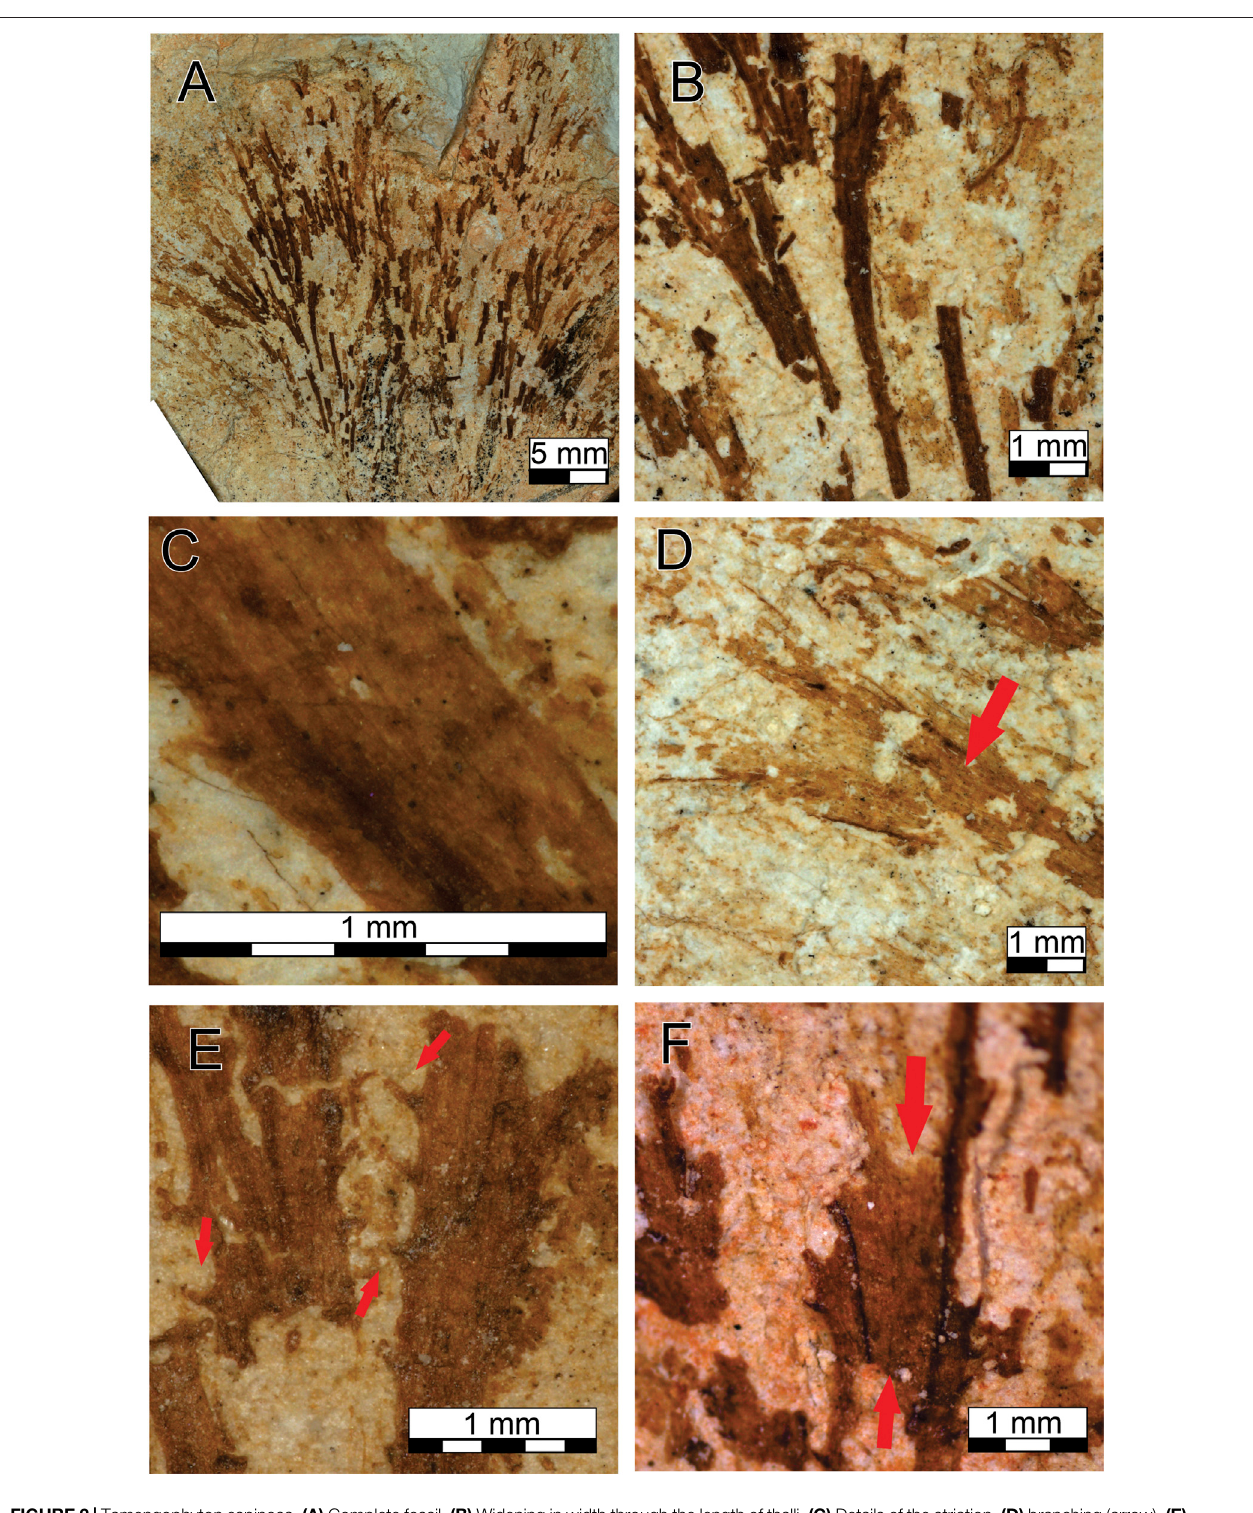
FIGURE 2 | Tamengophyton espinosa. (A) Complete fossil. (B) Widening in width through the length of thalli. (C) Details of the striation. (D) branching (arrow). (E) Details of the trichomes (arrows). (F) Details of the membrane (between the arrows).